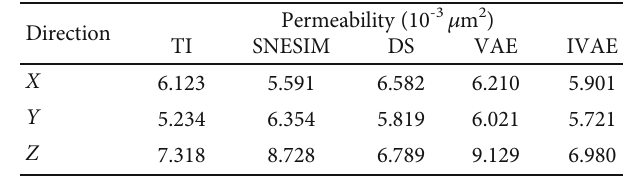
Table 4: Permeability of the TI and average permeabilities of 20 reconstructed images in three directions using IVAE, SNESIM, VAE, and DS.